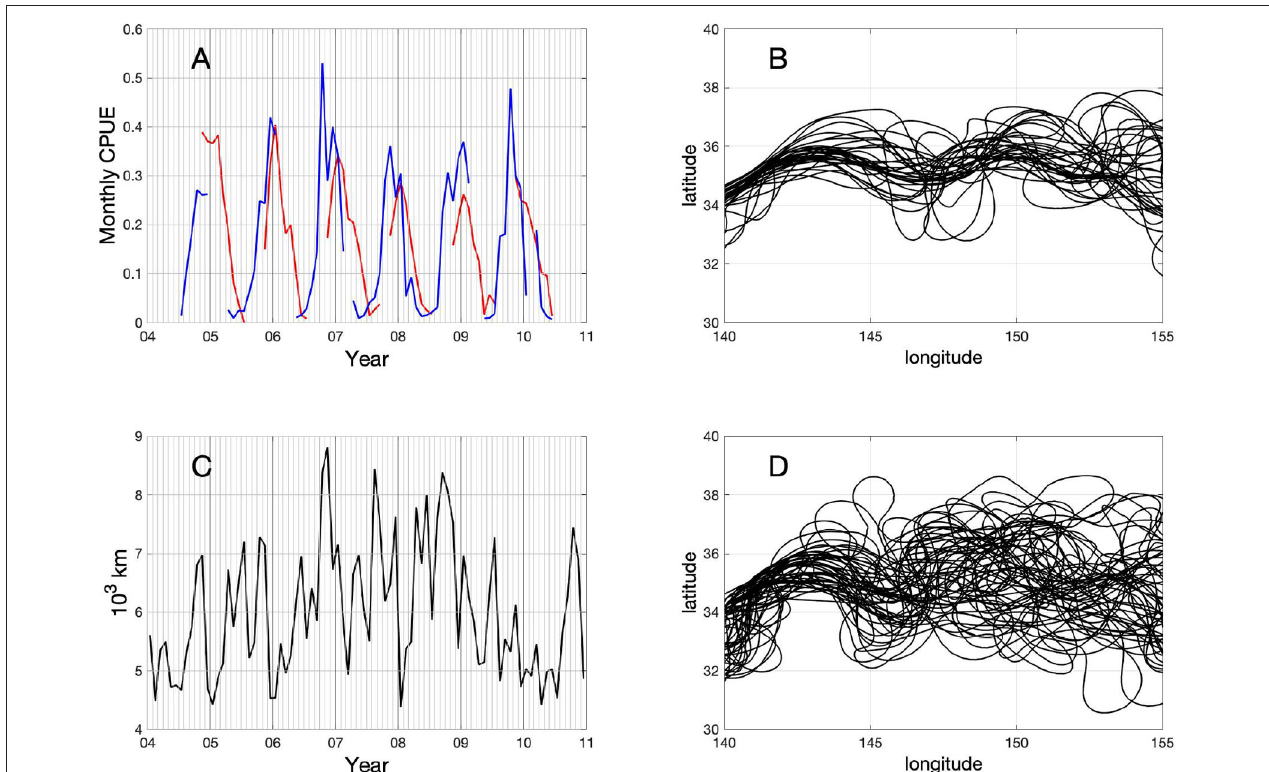
FIGURE 2 | Time series of (A) the monthly CPUE from 2004 to 2010 in the range 140–175 ◦ E for (red) southern region 25–36 ◦ N and (blue) northern region 36–45 ◦ N and of (C) monthly Kuroshio Extension path length (10 3 km) between 140 and 175 ◦ E. Monthly averaged paths of the Kuroshio Extension defined by the longest contour of sea surface height (SSH) at 0 m using FORA-WNP30 data for (B) stable paths for the years 2004, 2005, and 2010, and (D) unstable paths during the period 2006–2009. The abscissa is longitude ( ◦ E) and the ordinate is latitude ( ◦